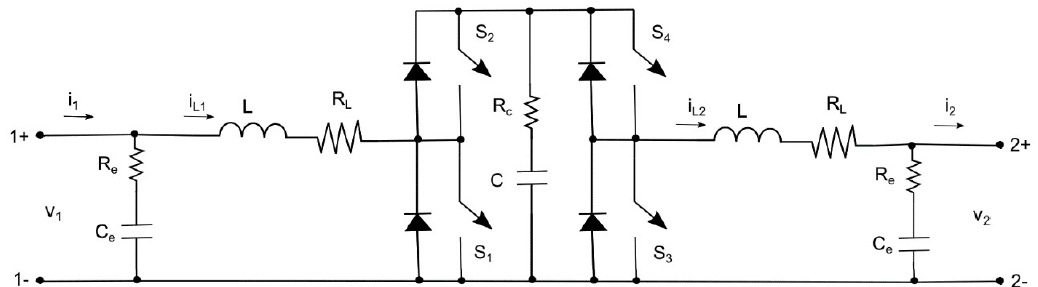
Figure 1. Schematic of the symmetrical Split-pi converter. Table 1. Summary of the operating modes of the Split-pi converter.